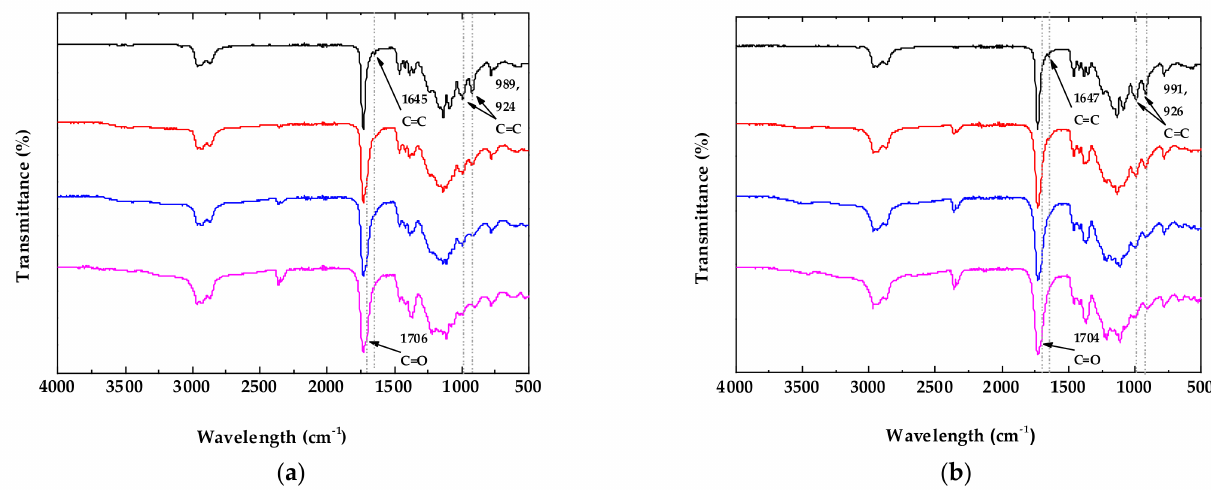
Figure 3. FTIR spectra of ( a ) P(TPAE- alt -AD) (black line), PE-Prop50 (red line), PE-Prop80 (blue line), and PE-Prop100 (ma- genta line) and ( b ) P(TPAE- alt -AD) (black line), PE-Glyc50 (red line), PE-Glyc80 (blue line), and PE-Glyc100 (magenta